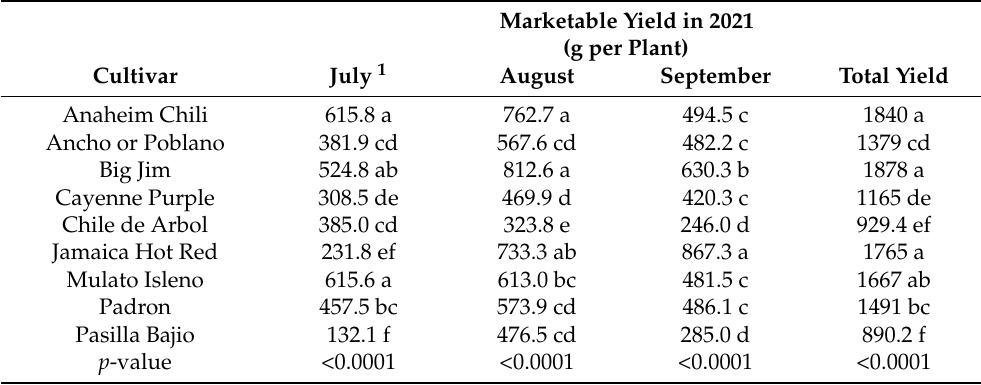
Table 3. Marketable yield of nine heirloom chile pepper cultivars grown in a container production system in Starkville, Mississippi, during the 2021 growing